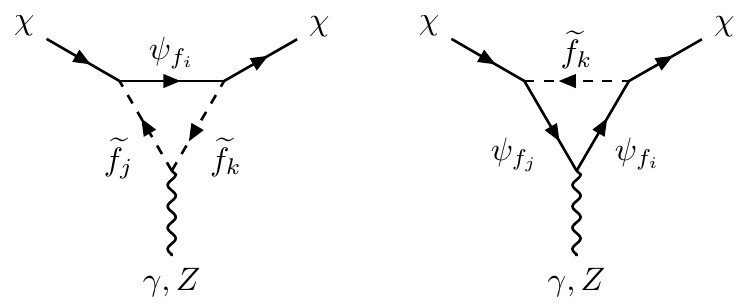
Figure 1 . Feynman diagrams for e(cid:11)ective DM- (cid:13)=Z